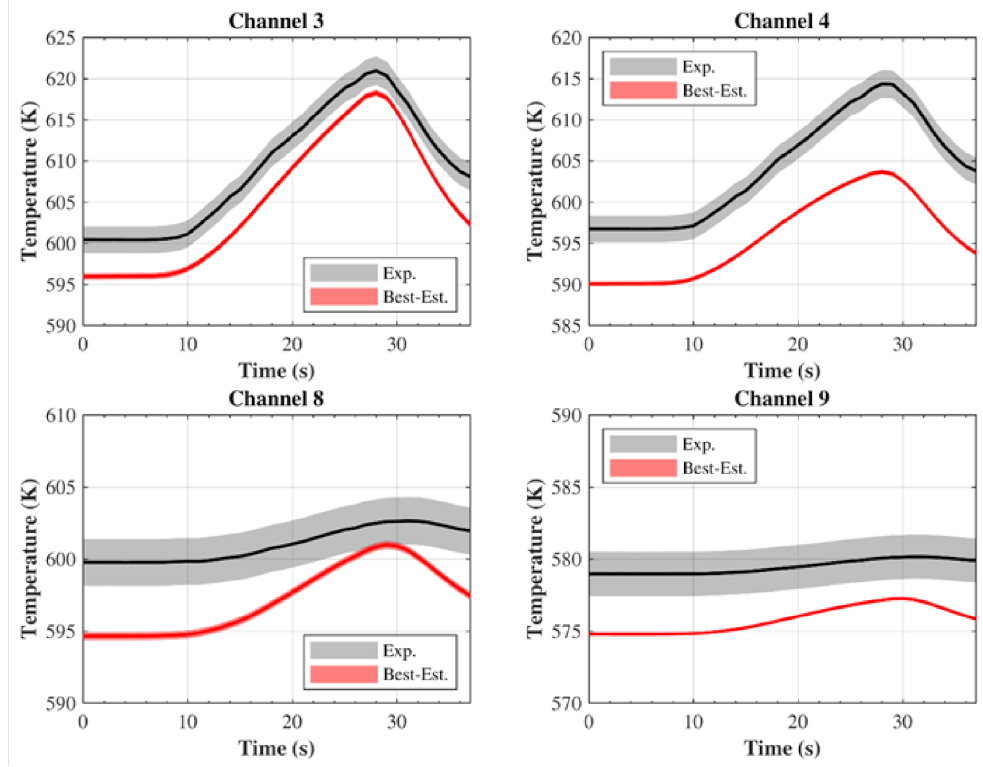
Figure 9. Outlet coolant temperature—300 kW/m 2 , 10% valve opening